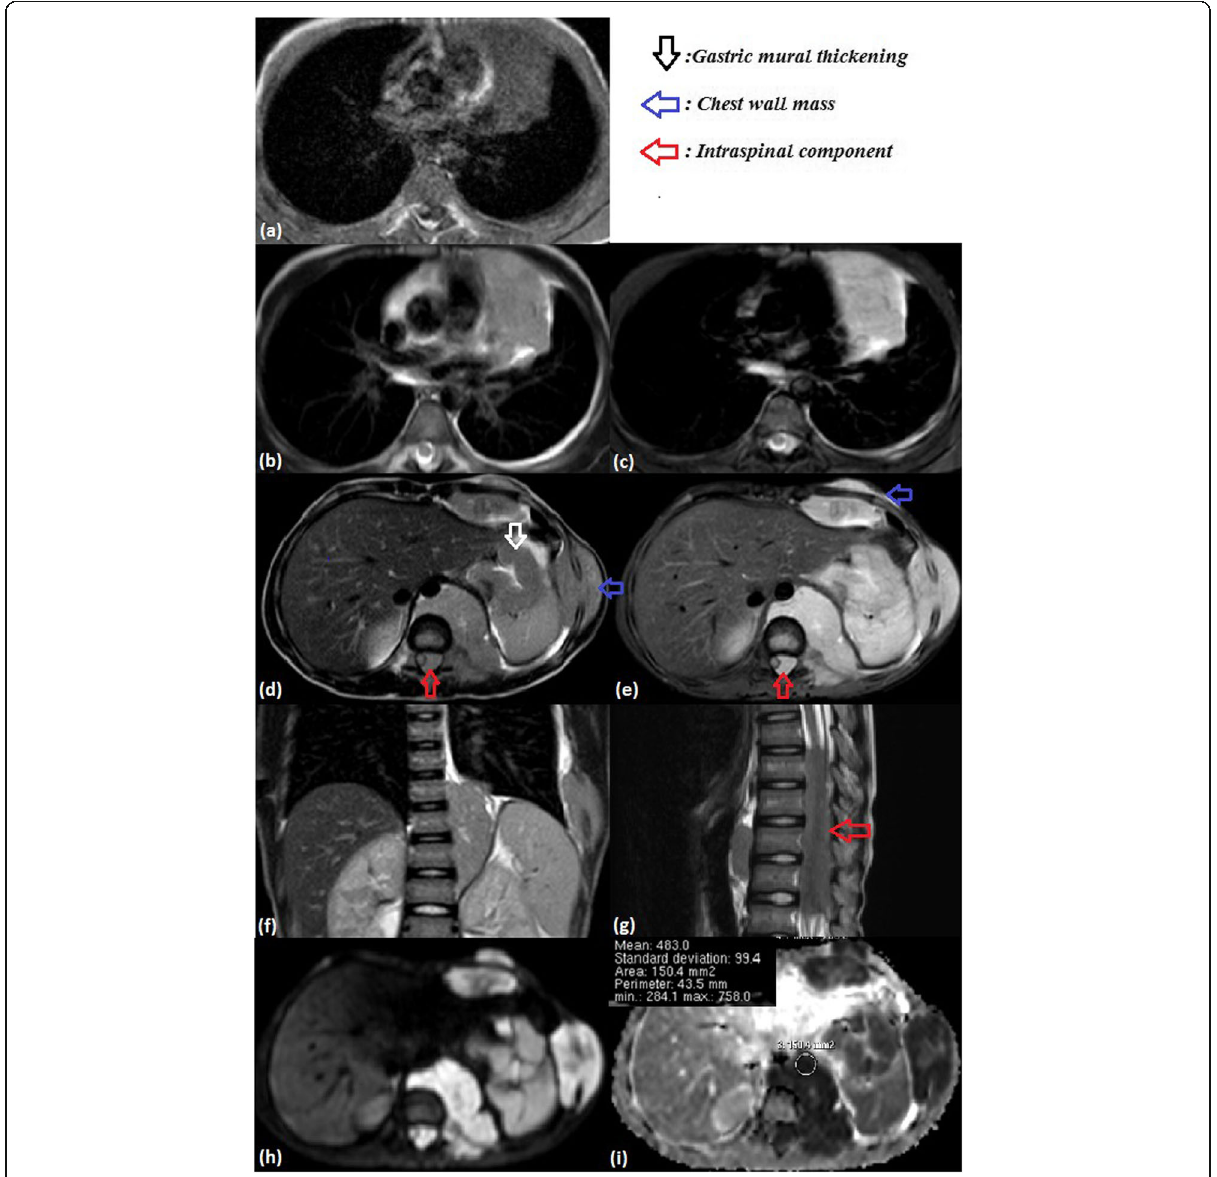
Fig. 5 NHL (Burkitt lymphoma): A 13-year-old male clinically presenting with constitutional symptoms (anorexia and weight loss) and left parasternal and left lateral lower chest wall swellings. a Axial T1 WI, b axial T2 WI, and c axial STIR WI show a well-defined rather ovoid-shaped anterior mediastinal mass displaying intermediate T1, relatively bright T2 and bright STIR signal intensities. d Axial T2 WI, e axial STIR WI, and f coronal T2 WI show another oblong-shaped posterior mediastinal (left paravertebral) mass displaying similar signal characteristics. It extends from the level of D9 down to D12 vertebra. Intraspinal extension in the form of a large epidural soft tissue component is seen opposite D7/8 down to D12 vertebra on the g sagittal T2 WI with evident displacement and compression of the dorsal cord. The lesions show restricted diffusion by being bright on the h DWI and dark on the i ADC map: ADC mean = 0.507 × 10 − 3 mm 2 /s and ADC min = 0.343 × 10 − 3 mm 2 /s. Associated findings: left parasternal and left lateral lower chest wall soft tissue lesions (seen encasing the related ribs). The upper abdominal cuts revealed circumferential gastric mural thickening. Both display similar signal characteristics to the aforementioned mediastinal masses. Minimal left pleural